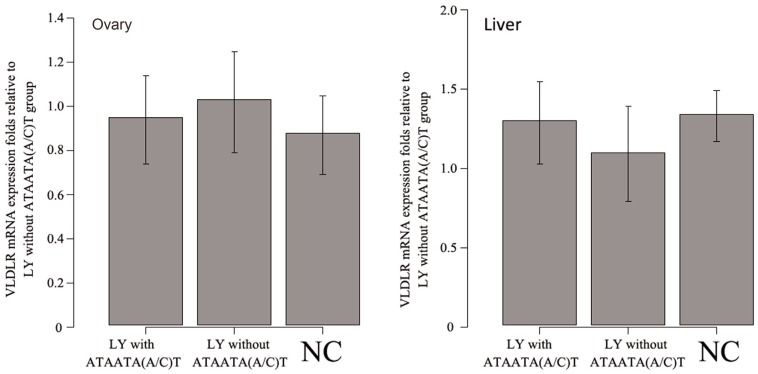
Comparison of VLDLR mRNA expression in Lueyang (LY) chickens with or
without ATAATA(A/C)T and in Nick Chick (NC) chickens. LY without the
ATAATA(A/C)T group was used as a calibrator. The expression levels of VLDLR
mRNA in LY with ATAATA(A/C)T and NC are shown as the fold-change relative to
the calibrator. The columns represent the mean ± SD of the fold change for LY
with ATAATA(A/C)T (n=6), LY without ATAATA(A/C)T (n=6) and NC (n=6) in liver
and ovary. There was no significant difference (p > 0.05) in VLDLR mRNA
expression among the groups within a given organ (liver and ovary). Statistical
significance was test by ANOVA followed by Duncan's multiple range
test.